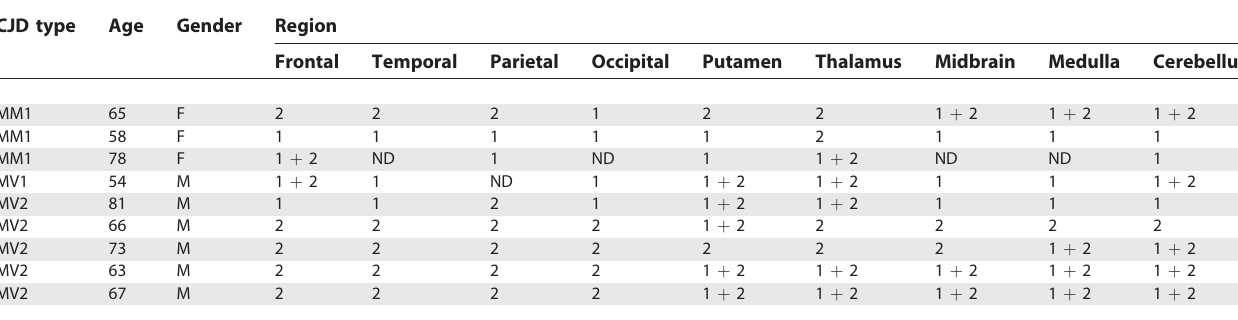
Table 3. Different PrP Sc Types in Defined Central Nervous System Regions of sCJD Patients CJD